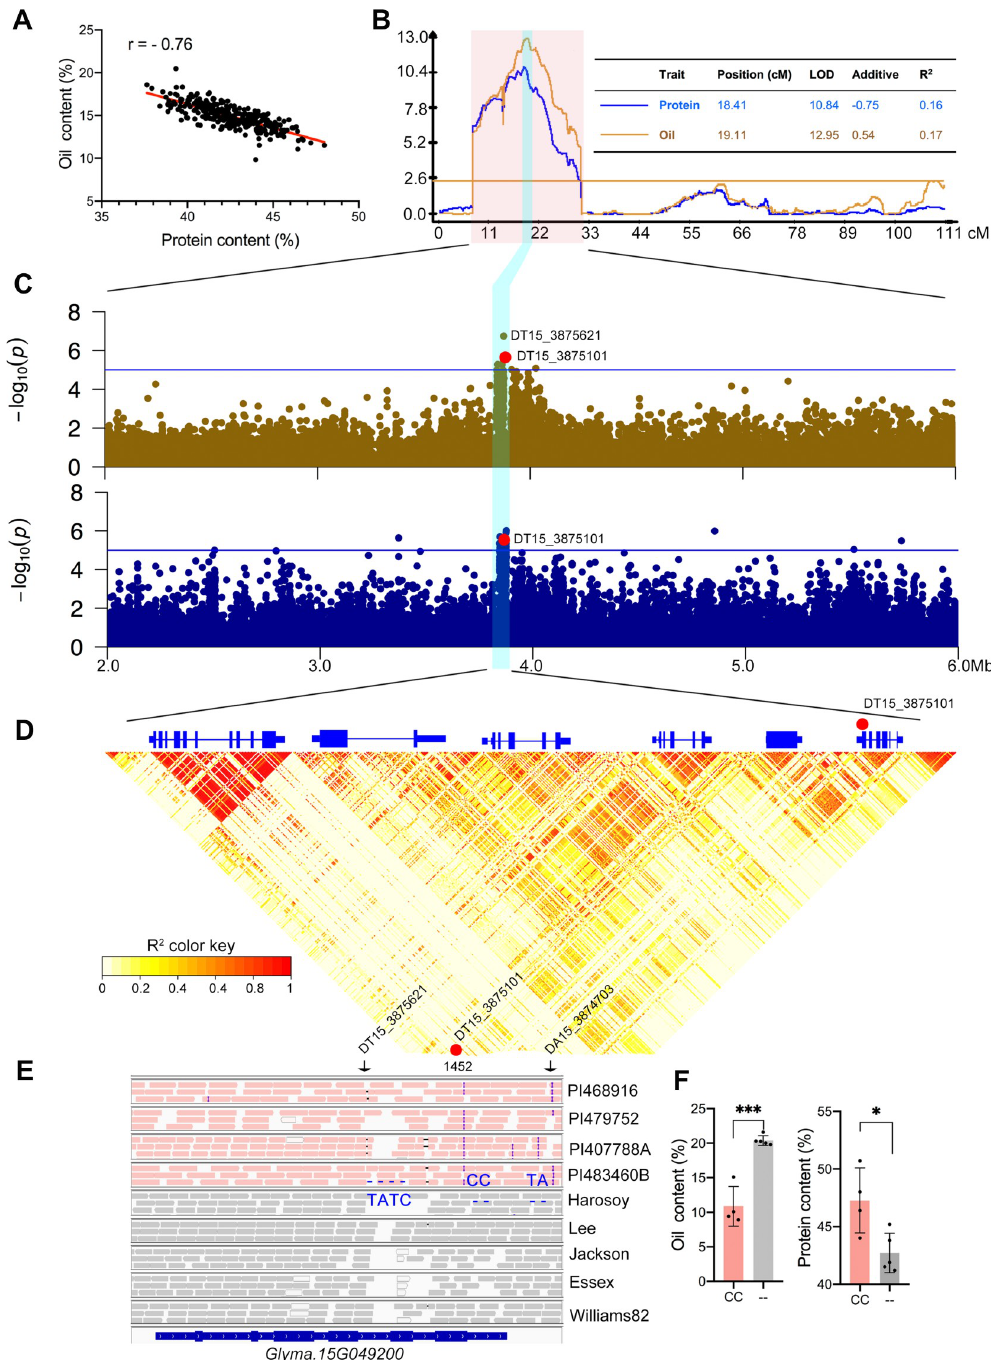
Fig 1. Identification of the major QTL on chromosome 15 and its underlying candidate gene. ( A ) Seed oil and protein from RILs exhibited a negative correlation. ( B ) Linkage mapping using RILs identified two overlapping QTLs on Chr15 for oil and protein, respectively. ( C ) Regional association analysis identified a cluster of variants significantly associated with oil and protein content. The red solid dot represents a significant association (DT15_3875101). ( D ) Six gene models and the LD pattern within the significant 34-kb region. ( E ) IGV view of variant patterns between high protein and low protein soybean genotypes. The two variants occurring in the non-coding region were indicated with arrows in black. Variant patterns at the three sites were shown as TATC/---- (alternative/reference), --/CC, and --/TA. ( F ) The CC deletion (- -) at DT15_3875101 is highly correlated with high-oil, and low-protein content. CC presence is indicated by CC. � and ��� indicate the significance at p < 0.05 and p < 0.001,